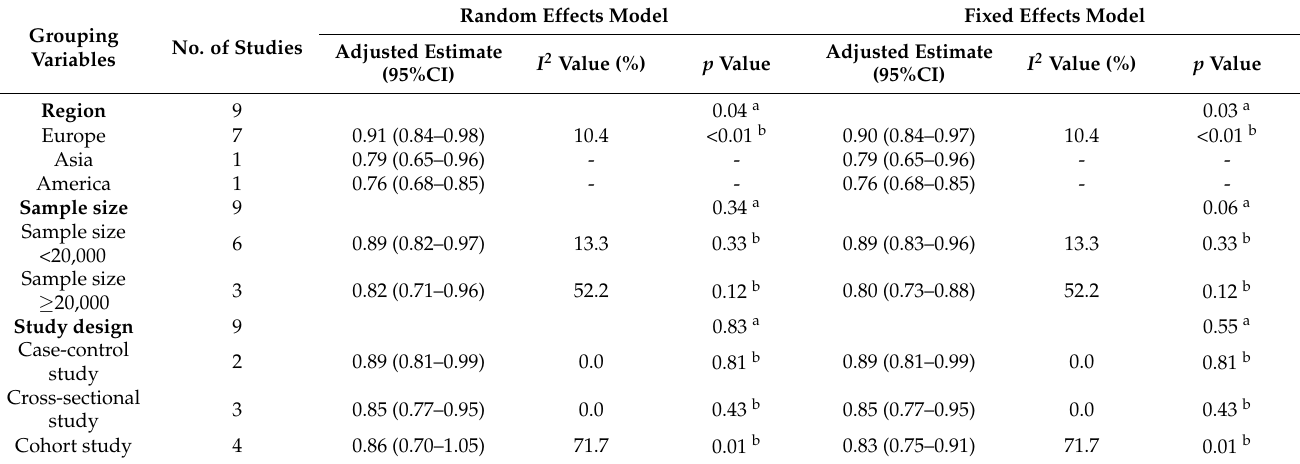
Table 4. Subgroup analyses of the association between influenza vaccination and SARS-CoV-2 infection. Grouping